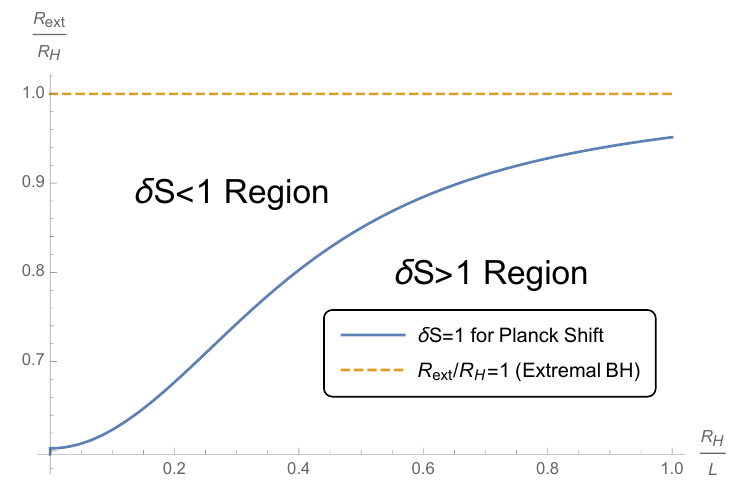
Figure 7 . Above is a plot of R ext =R H as a function of R H =L for d = 3 (plot of the square root of the right hand side of eq. (D.9)). The solid line represents the closest one can get to the extremal regime (i.e. R ext =R H = 1 represented by the dashed line) before a proper Planck length shift of the horizon results in (cid:14)S <